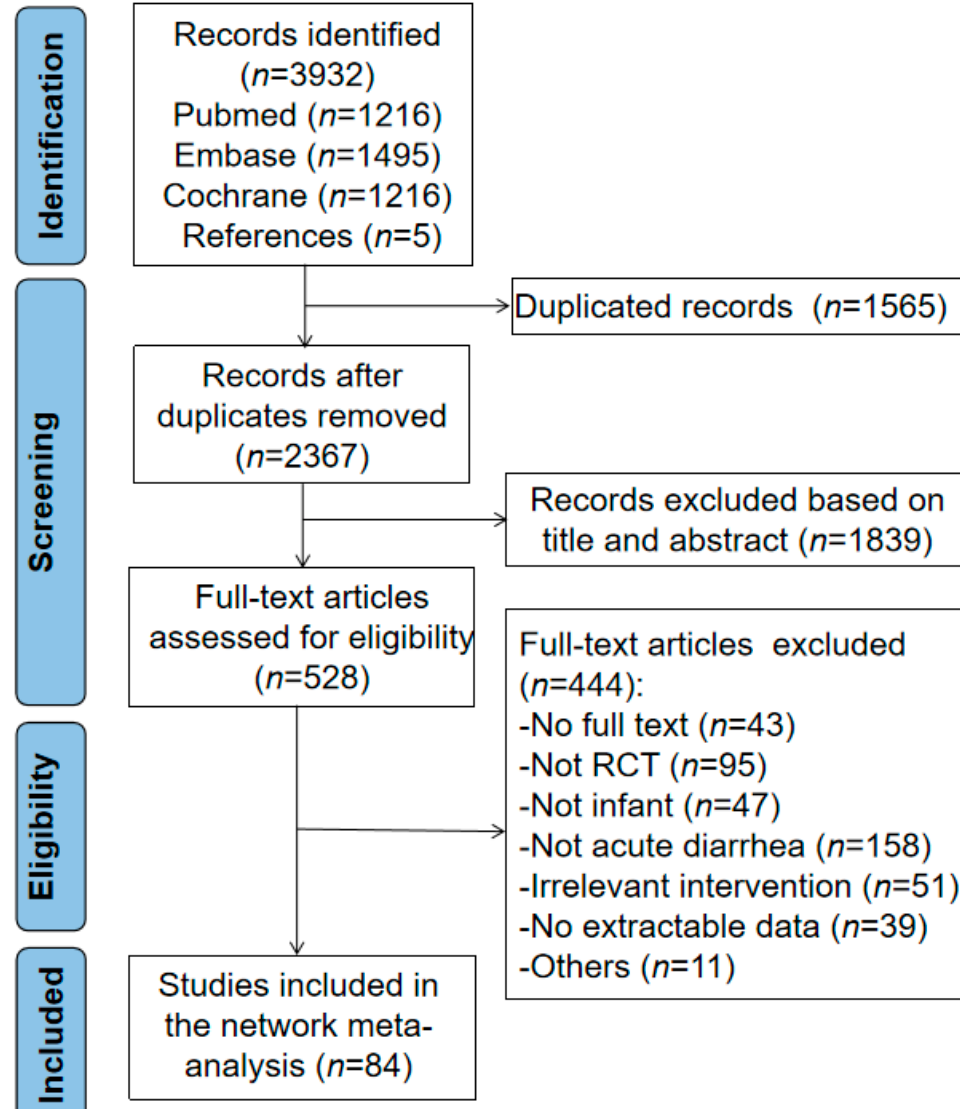
Figure 1. PRISMA flow diagram for the Bayesian network meta-analysis.